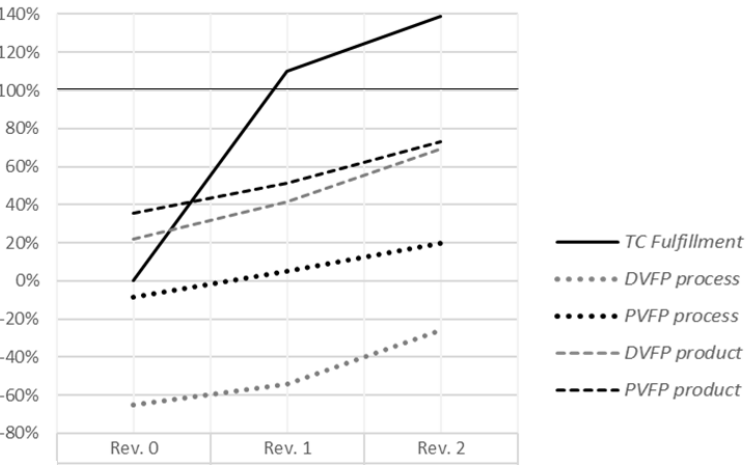
Figure 6. Comparison between cost and value